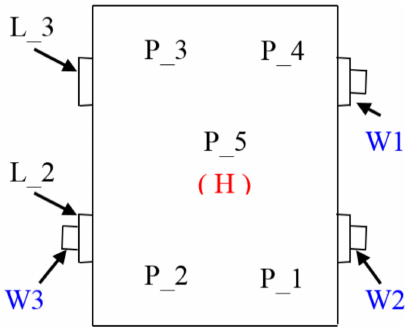
Figure 4. Arrangement of the points of forces impact (L)–(W)–(P) and measurement of vibration (P) and noise